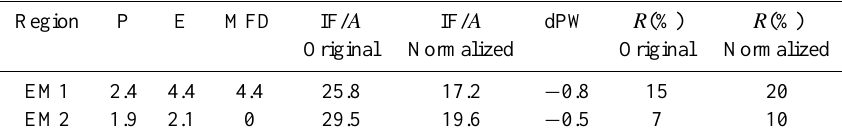
Table 3. Mean WVB components and R values for the EM1 and EM2 regions delineated in Fig. 1c for 480 major rain days (MRDs) in Israel (defined in Sect. 2.4) during the winters of 1985–1993, based on Malka (2006). Symbols are as in the text. IF/ A and R values are presented in original and normalized forms (see Sect. 2.3). Region P E MFD IF/ A IF/ A dPW R (%) R (%) Original Normalized Original